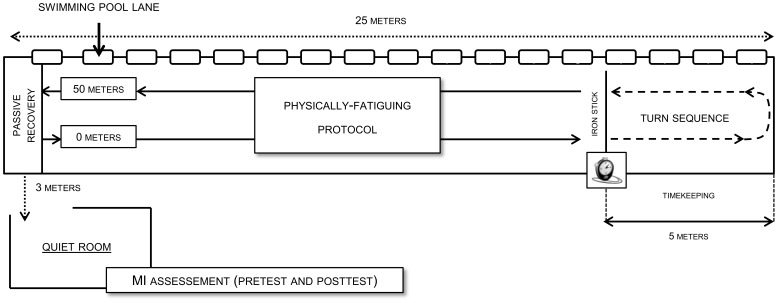
Experimental setting.MI  =  motor imagery.